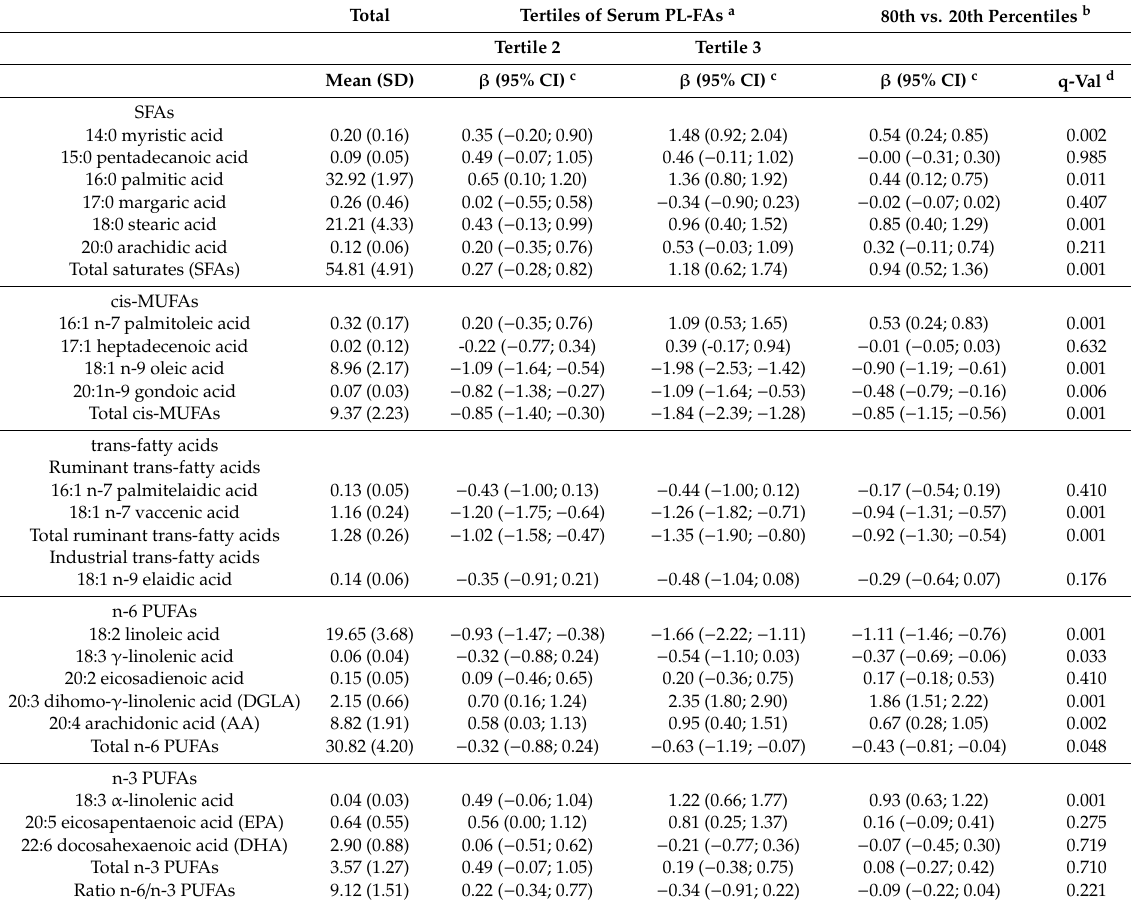
Table 3. Mean percentage of serum phospholipid fatty acids and their association with body mass